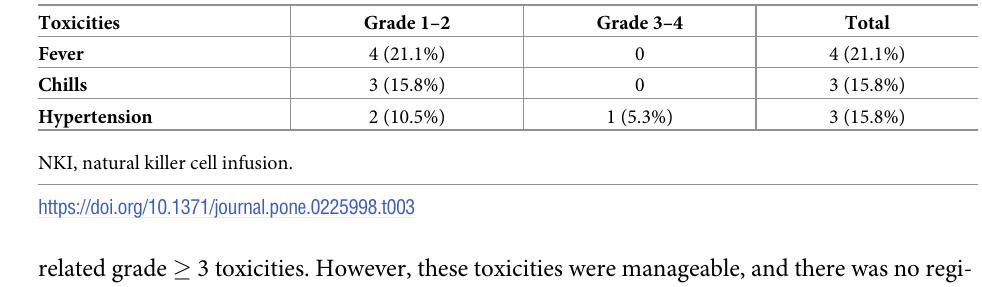
Table 3. NKI-related immediate toxicity profiles in 19